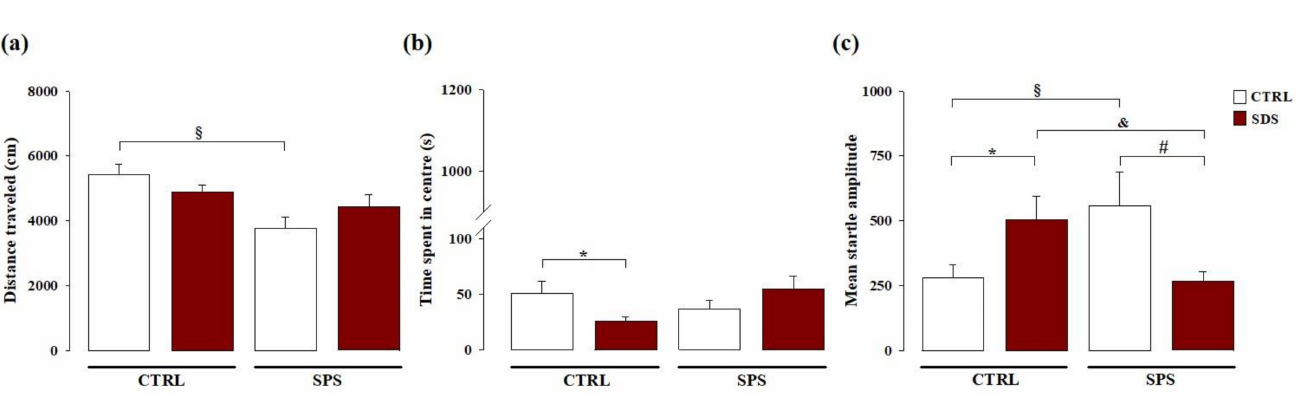
Figure 2. Long-term effects on locomotor activity, hyperarousal, and anxiety-like behavior induced by SDS, SPS, or the combination of both stressors. Long-term effects induced by SDS, SPS, or both stressors on the ( a ) distance traveled (cm) evaluated in the open field arena, ( b ) time spent in the center of the arena in the open field, and ( c ) mean startle amplitude in the acoustic startle response task. *, p < 0.05 vs. CTRL-CTRL group; §, p < 0.05 vs. CTRL-CTRL group; &, p < 0.05 vs. SDS-CTRL group; #, p < 0.05 vs. CTRL-SPS group. (N = 8–12 rats per group or N = 8–11 rats per group, in the open field or acoustic startle response tasks,